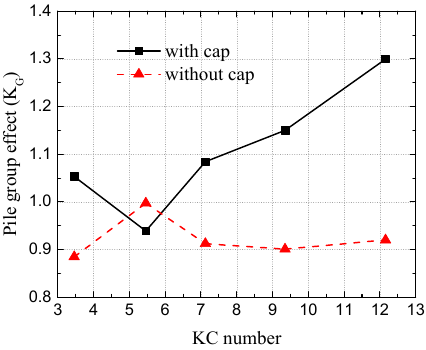
Figure 9. Variations of the pile group effect versus various KC numbers with the tandem arrangement of the pile group. Table 2. Input parameters of five numerical